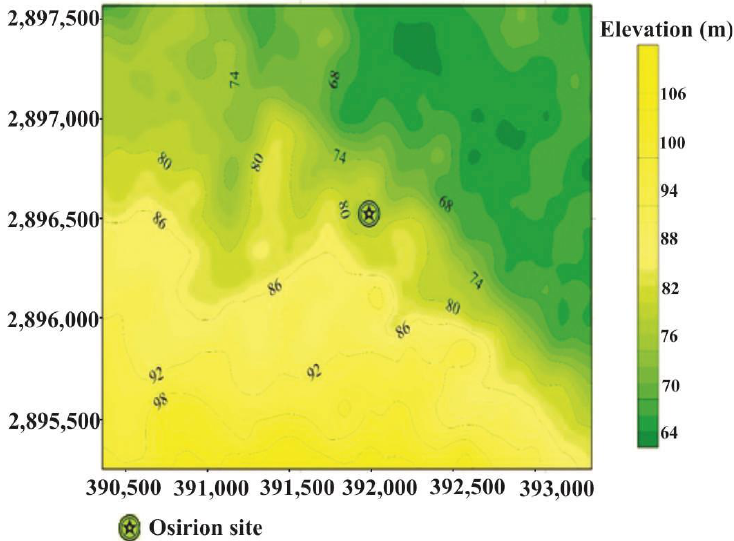
Figure 2. Elevation contour map of the study area.